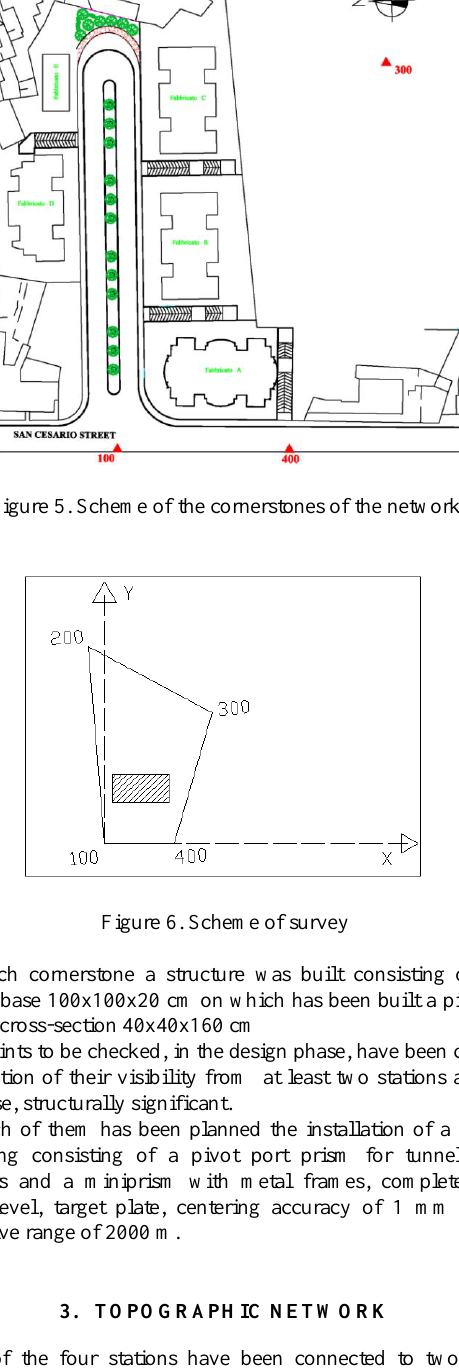
Figure 9. Control vertices located on the South and East